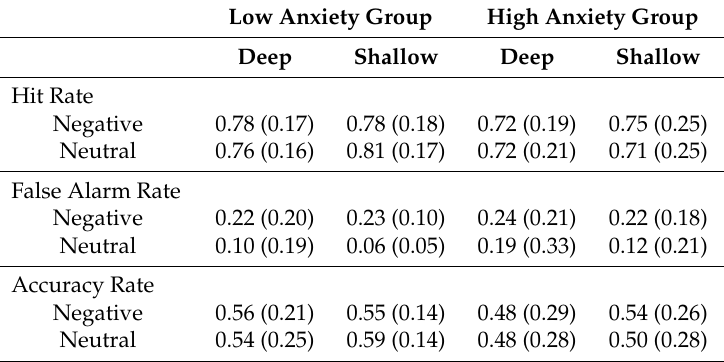
Table 2. Test 2: Memory for Foils and False Alarm Rate for Participants with High versus Low Trait Anxiety in the Deep and Shallow Encoding Condition.